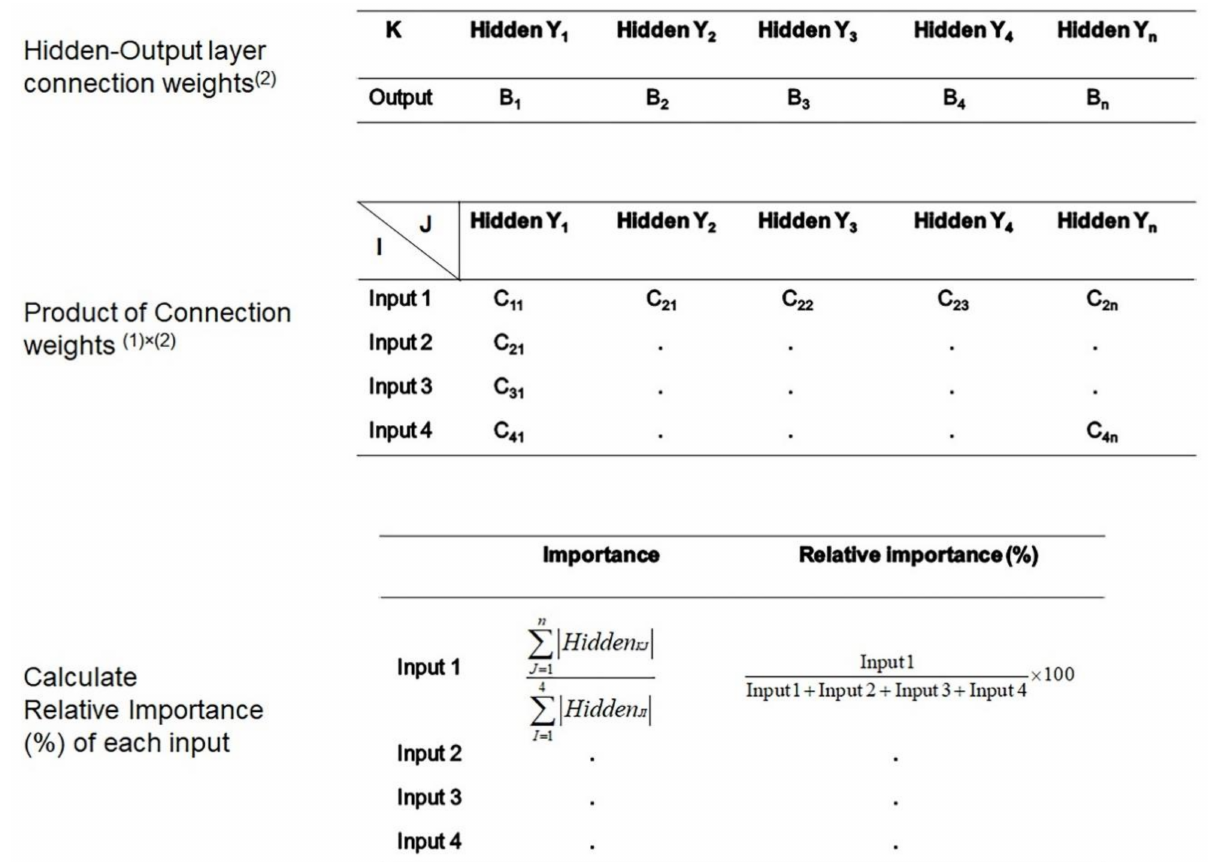
Figure 5. Schematic representation of Garson’s algorithm showing the different steps involved in the calculation of the relative importance ( RI ) of input parameters used in the ANN